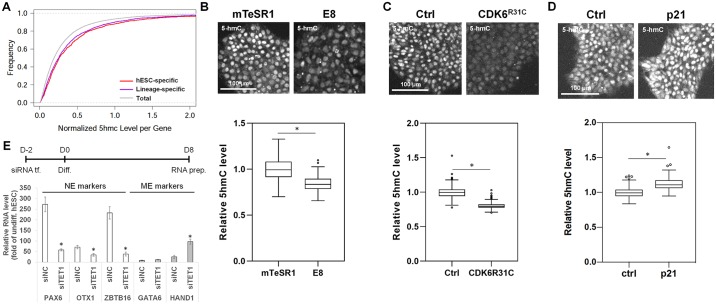
G1 length–driven 5-hmC accumulation is necessary for NE differentiation.(A) Empirical cumulative distribution of 5-hmC levels measured across whole gene bodies (including 1 kb upstream and downstream of genes) in H9 hESCs grown in mTeSR1 (U test: p-value < 2.2 × 10−16 for Lineage-specific versus Total, p-value < 2.2 × 10−16 for hESC-specific versus Total, and p-value = 0.04956 for Lineage-specific versus hESC-specific). (B) Immunofluorescence assay for 5-hmC in H9 cells grown either in mTeSR1 or in E8 (n = 187 for mTeSR1 and n = 202 for E8 from three independent experiments). (C and D) Immunofluorescence assay for 5-hmC in H9 cells grown in mTeSR1 overexpressing either CDK6R31C (C) or p21 (D) (panel C: n = 222 for Ctrl and n = 207 for CDK6R31C pooled from three independent experiments, panel D: n = 187 for Ctrl and n = 194 for p21 pooled from three independent experiments). (E) qPCR analysis of lineage markers in H9 cells transfected with TET1 siRNA and then differentiated for 8 d (n = 4). Error bars represent SD. *p < 0.01 (Student t test). Underlying data can be found in S1 Data. 5-hmC, 5-hydroxymethylcytosine; CDK, Cyclin-dependent kinase; Ctrl, control; Diff., differentiated; E8, Essential 8; GATA6, GATA binding protein 6; HAND1, Heart and neural crest derivatives expressed 1; hESC, human embryonic stem cell; ME, mesendoderm; NC, negative control; NE, neuroectoderm; OTX1, Orthodenticle homeobox 1; PAX6, Paired box 6; qPCR, quantitative PCR; RNA prep., RNA preparation; siRNA, small interfering RNA; TET, Ten-eleven translocation; tf., transfection; Total, total protein coding genes; ZBTB16, Zinc finger and BTB domain containing 16.